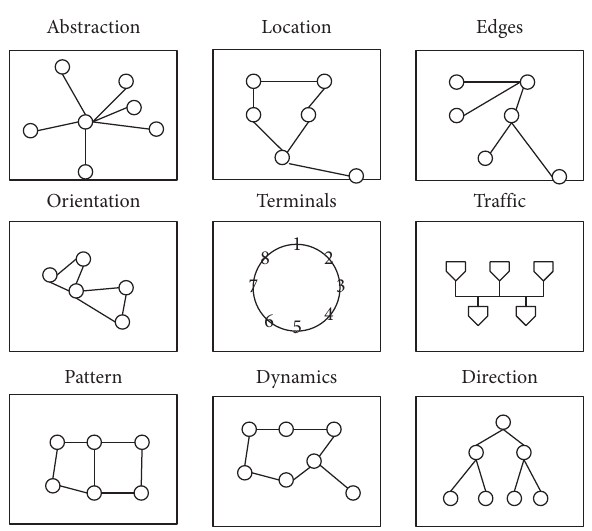
Figure 3: Evaluation steps of verification